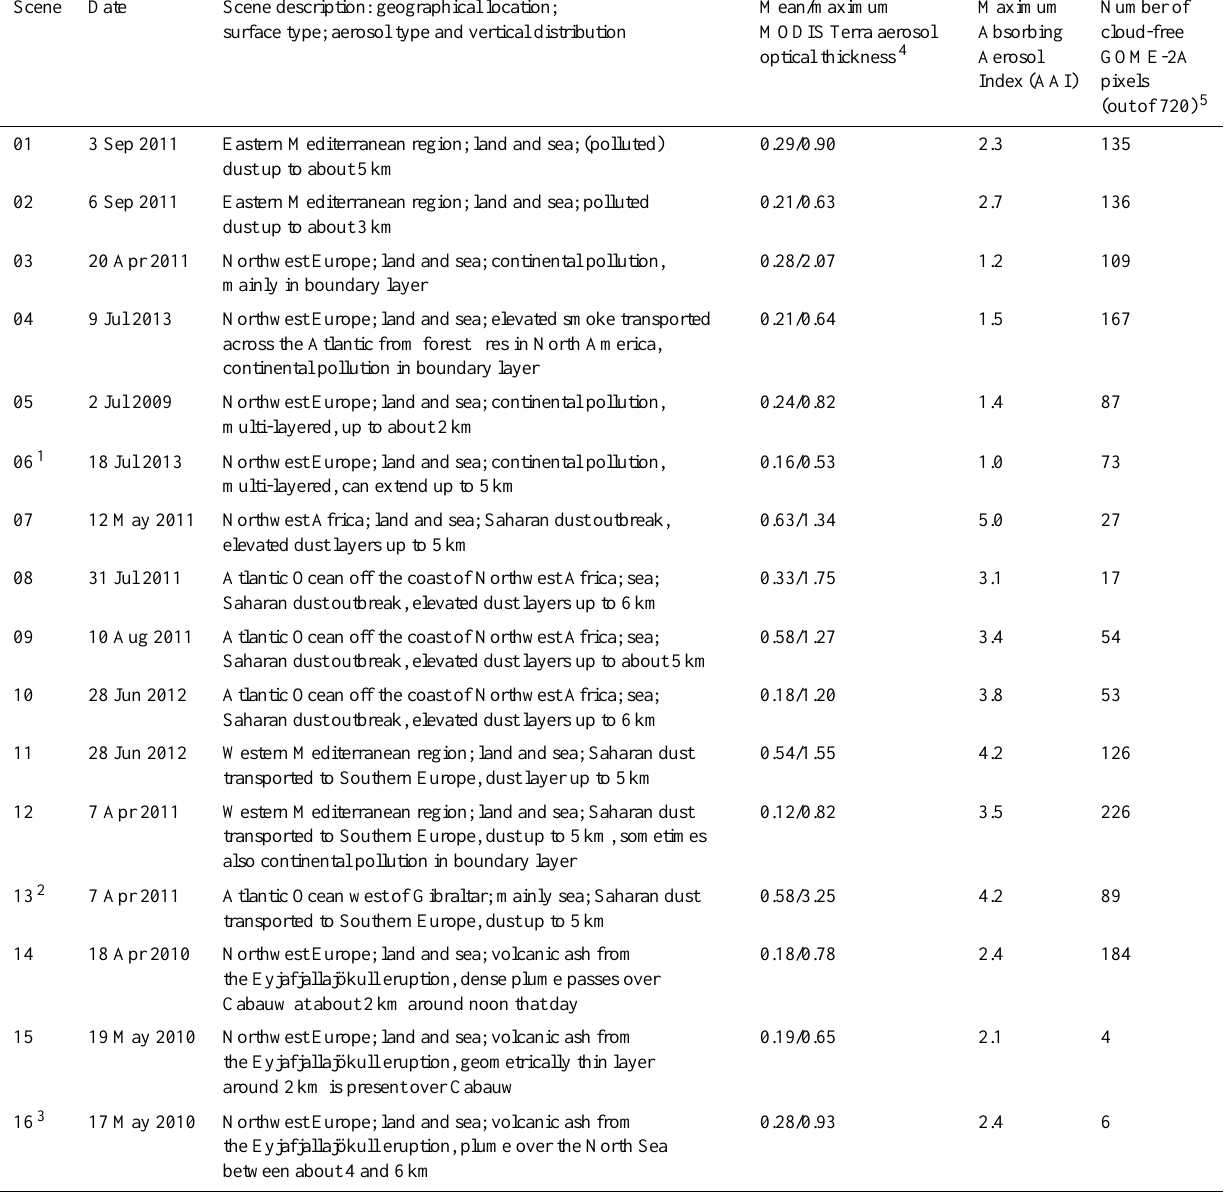
Table 4. Description of the 16 aerosol scenes used in the GOME-2A retrieval experiments. Here, an aerosol scene is a 3-minute granule of GOME-2A observations, which consists of 720 pixels in